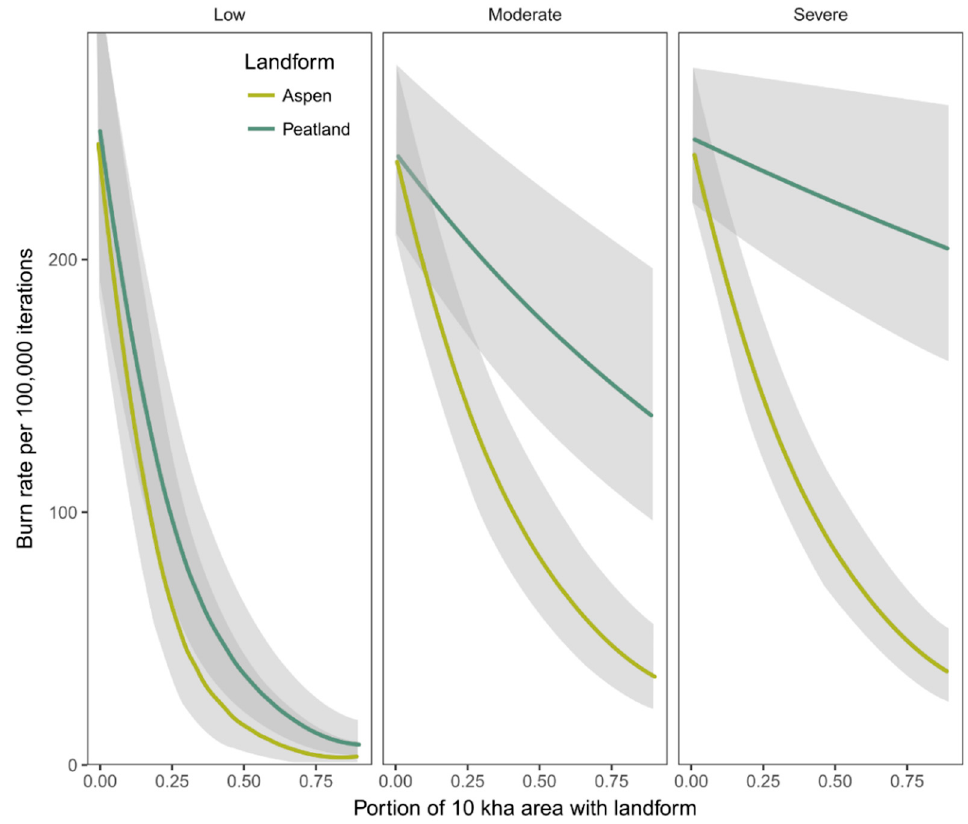
Figure 4. Generalized linear model of burn count per 10 kha hexel, showing the e ff ect of aspen and peatland fractional cover on the burn rate in each drought scenario. The model intercept, at zero peatland and aspen cover, represents the burn rate in a hexel composed entirely of conifer, mixedwood, and non-peatland grasslands corresponding to average landscape values (Table 2). The 95% confidence interval of the prediction is shown for each model response curve.